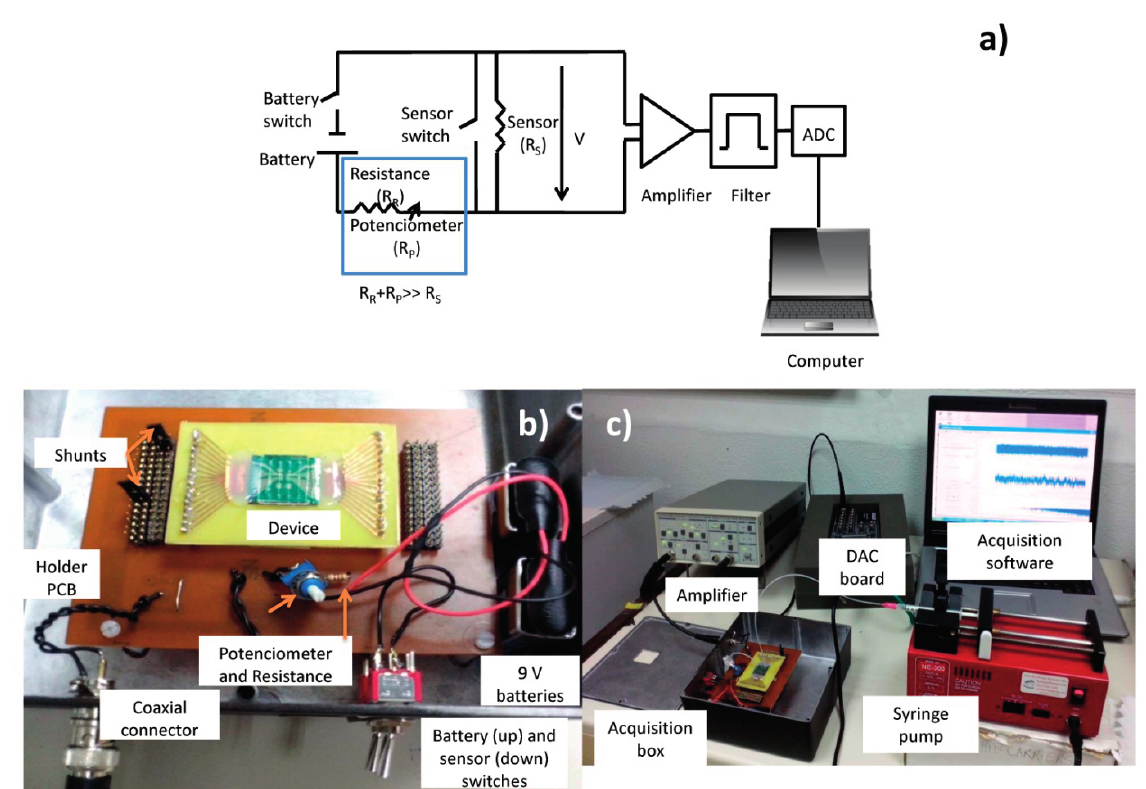
Figure 8. Acquisition Setup. ( a ) Electrical circuit of the acquisition setup; ( b ) Biasing box; ( c ) Acquisition setup